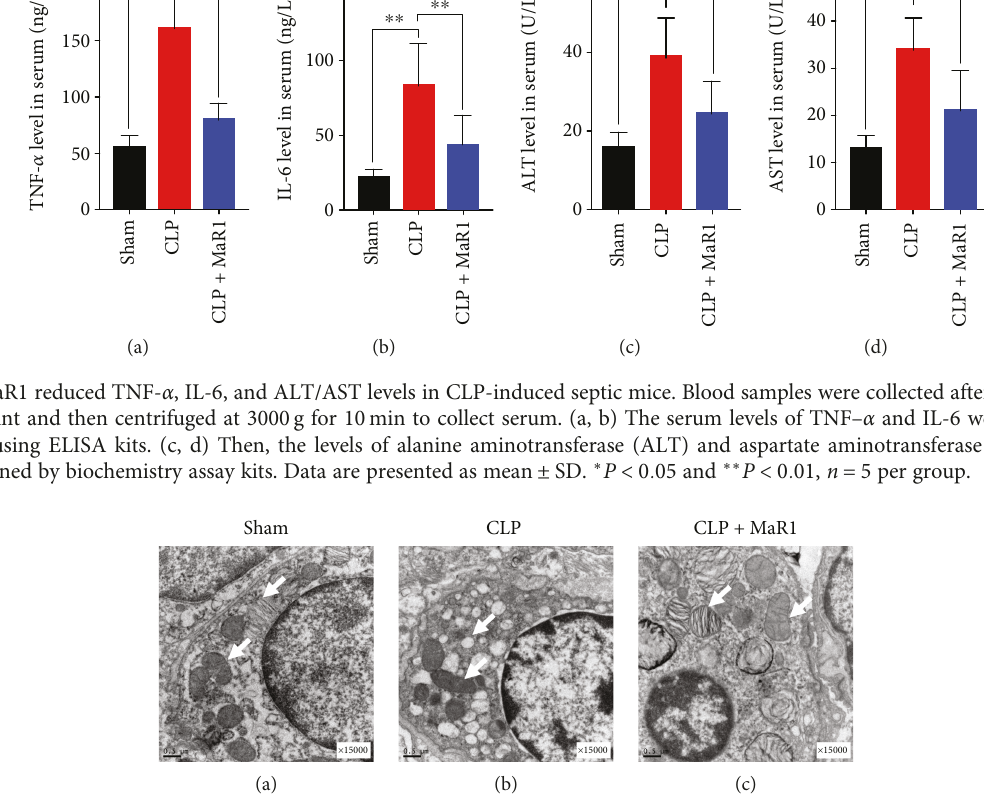
Figure 4: MaR1 mitigated mitochondrial damage in CLP-induced septic mice. For electron microscopy experiments, the lung tissues were harvested 24h after CLP and the e ff ect of MaR1 was assessed by transmission electron microscopy analysis (original magni fi cation × 15,000). The mitochondrial ultrastructure changes in three experimental groups were indicated by the white